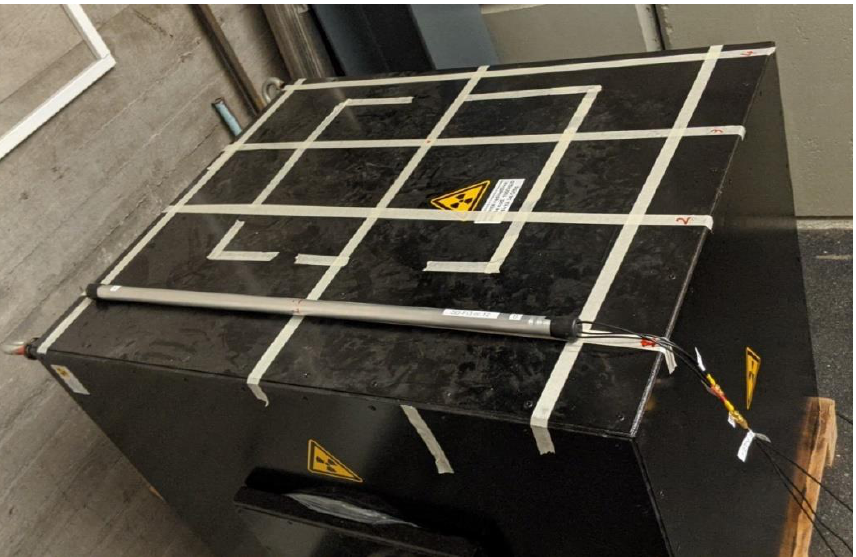
Figure 16. The AmBe neutron and gamma source enclosed in a 95 × 75 × 85 cm 3 iron box along with its moderator. A SciFi detector in one of the measurement positions is also shown.